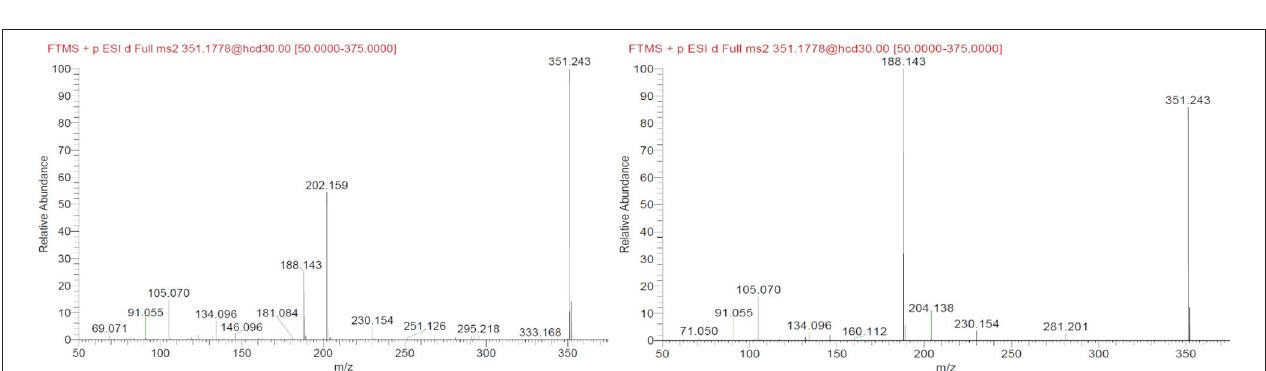
FIGURE 5 | Spectra of the unknown nodes with precursor m/z = 619.365, 437.281, and 403.238.